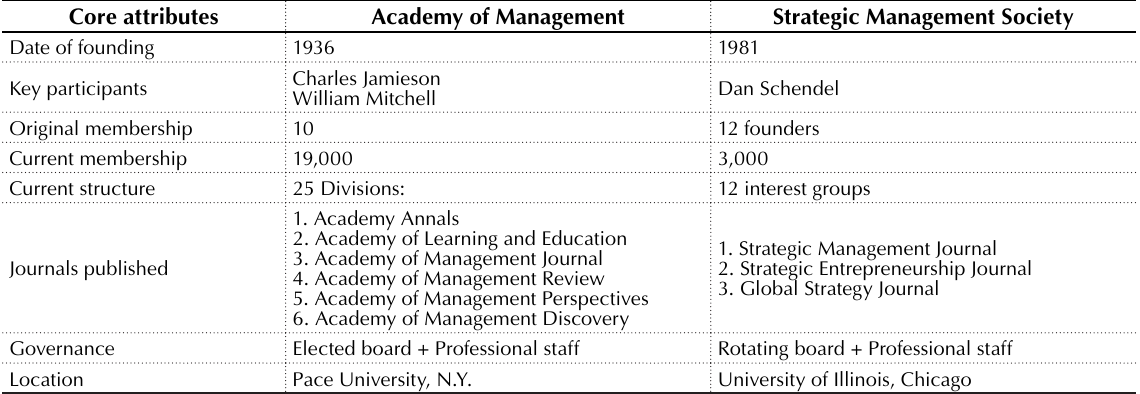
Table 2. Profiles of two management societies: Academy of Management and Strategic Management